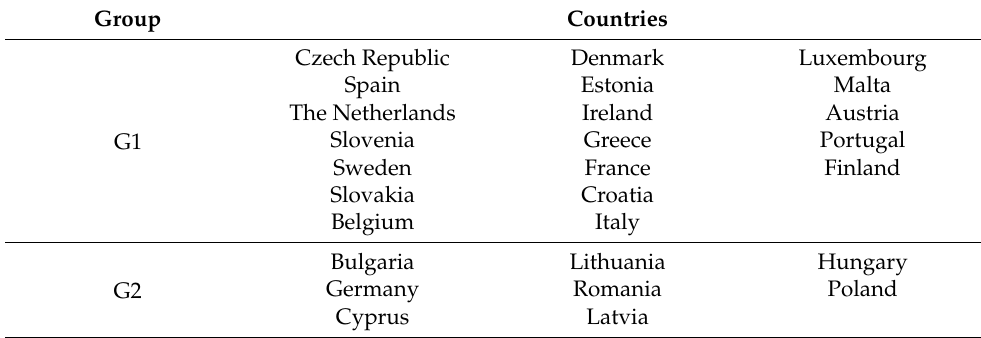
Table 2. Subdivision made in the graphical representation of Pearson’s coefficient.